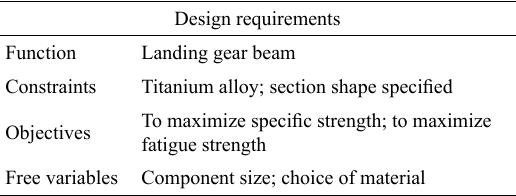
Table 2. Design requirements for the landing gear beam.